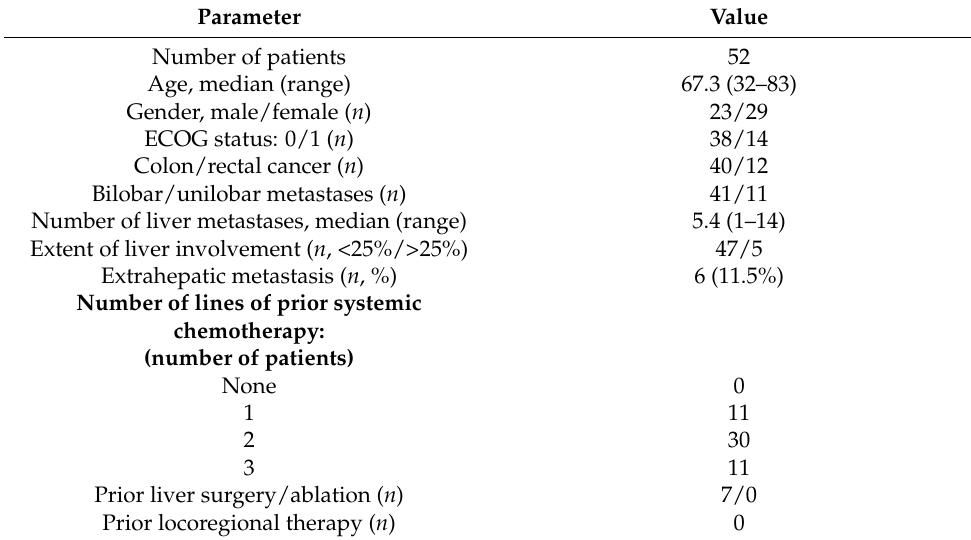
Table 1. Patient